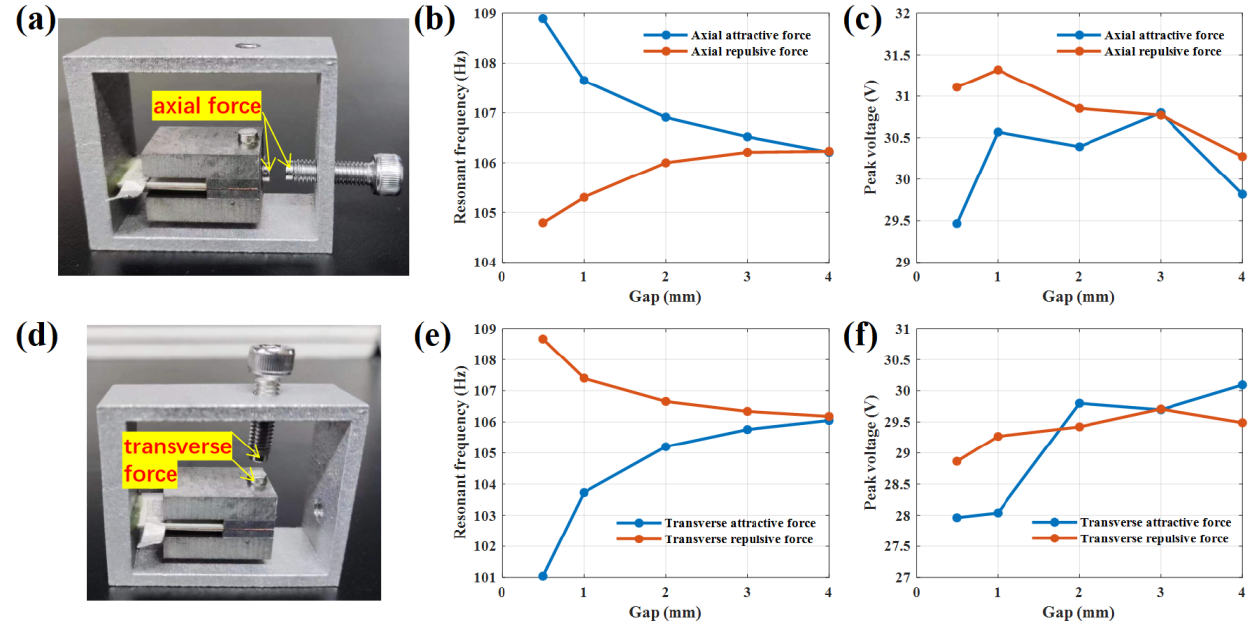
Figure 6. PVEH frequency modulation method and result by magnetic force: ( a ) PVEH prototype with axial magnetic force; ( b ) Resonant frequency and ( c ) voltage at open-circuit (load resistance of 10 MΩ) by axial attractive force and repulsive force with a different magnetic gap; ( d ) PVEH prototype with transverse magnetic force; ( e ) Resonant frequency and ( f ) voltage at open circuit (load resistance of 10 MΩ) by transverse attractive force and repulsive force with different magnetic gap.